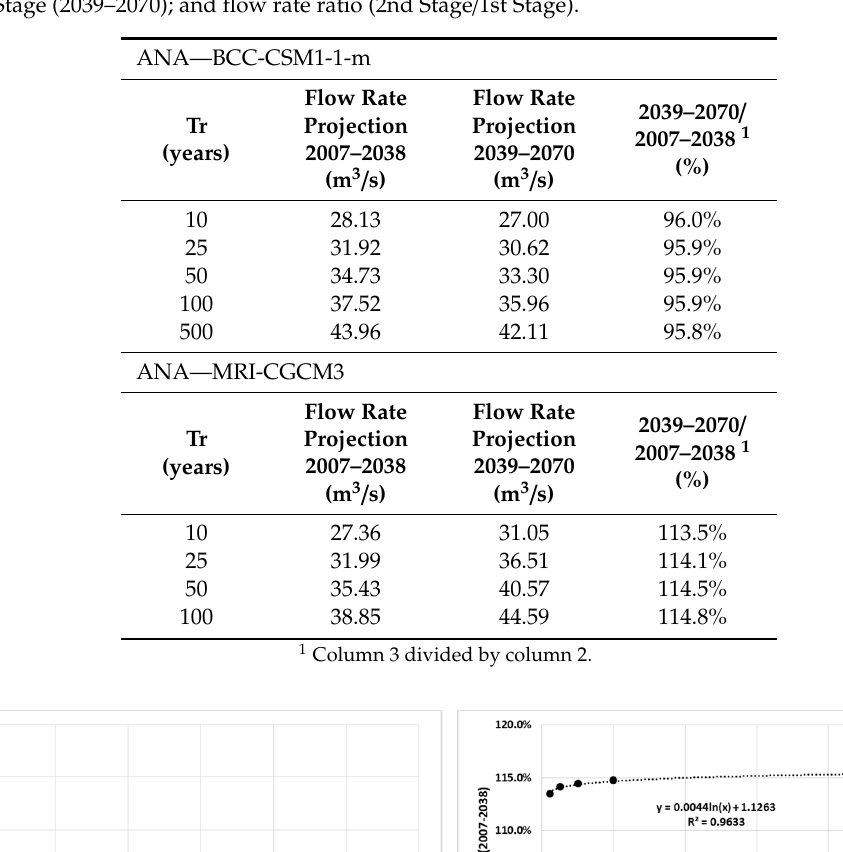
Table 3. Projection ratio 2nd Stage (2039–2070)/1st Stage (2007–2038) for the flow rate, flood surface, inhabitants potentially affected and flood damage’s economic value.